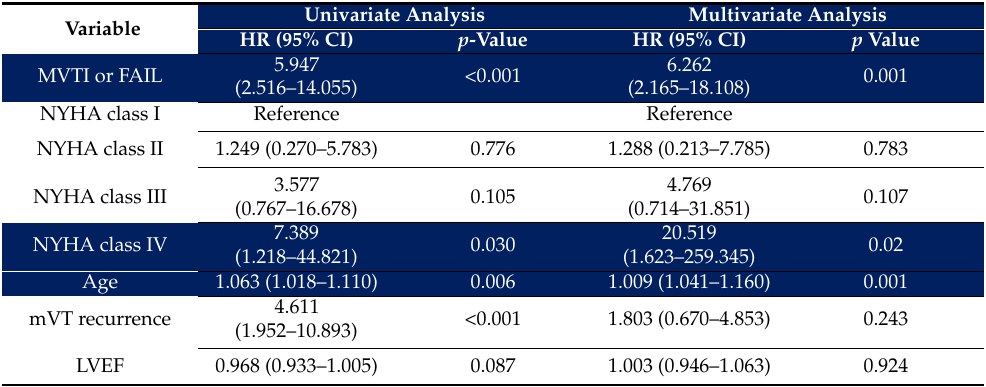
Table 3. Univariate and multivariate Cox regression analysis for prediction of survival without death in post-RFCA ES patients. ES = electrical storm, RFCA = radiofrequency catheter ablation, mVT = monomorphic ventricular tachycardia, LVEF = left ventricular ejection fraction. Univariate Variable